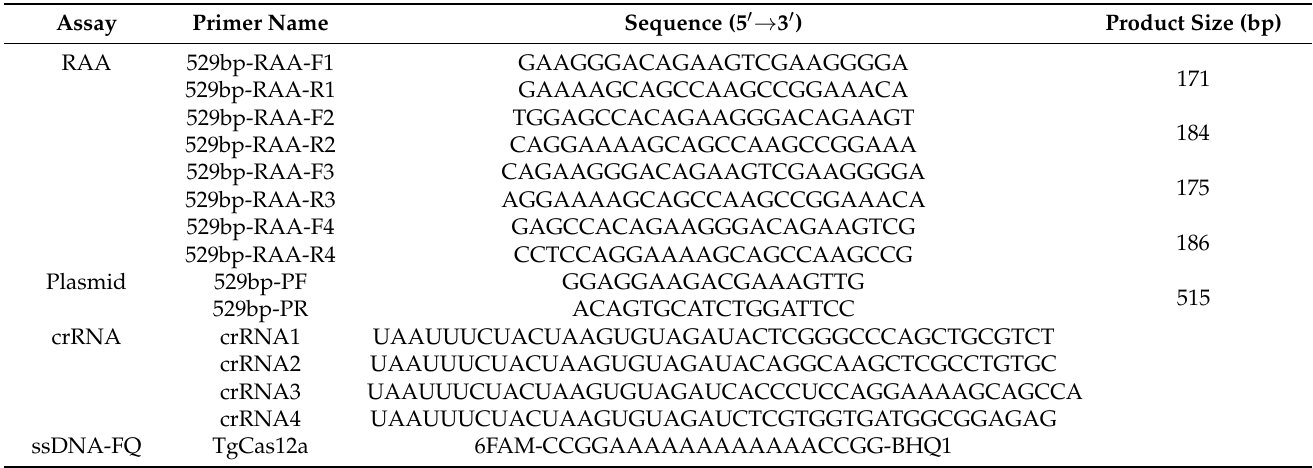
Table 1. Primer sequences for RAA, plasmid, crRNA and ssDNA-FQ.